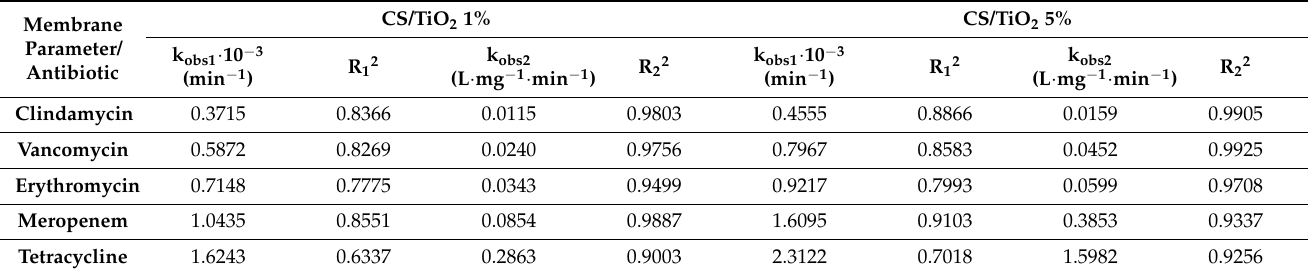
Figure 15. The plots of 1/C vs. irradiation time (t) for ( a ) CS/TiO 2 1% and ( b ) CS/TiO 2 5% membranes. Table 6. Values for the rate constants k obs1 and k obs2 and corresponding correlation